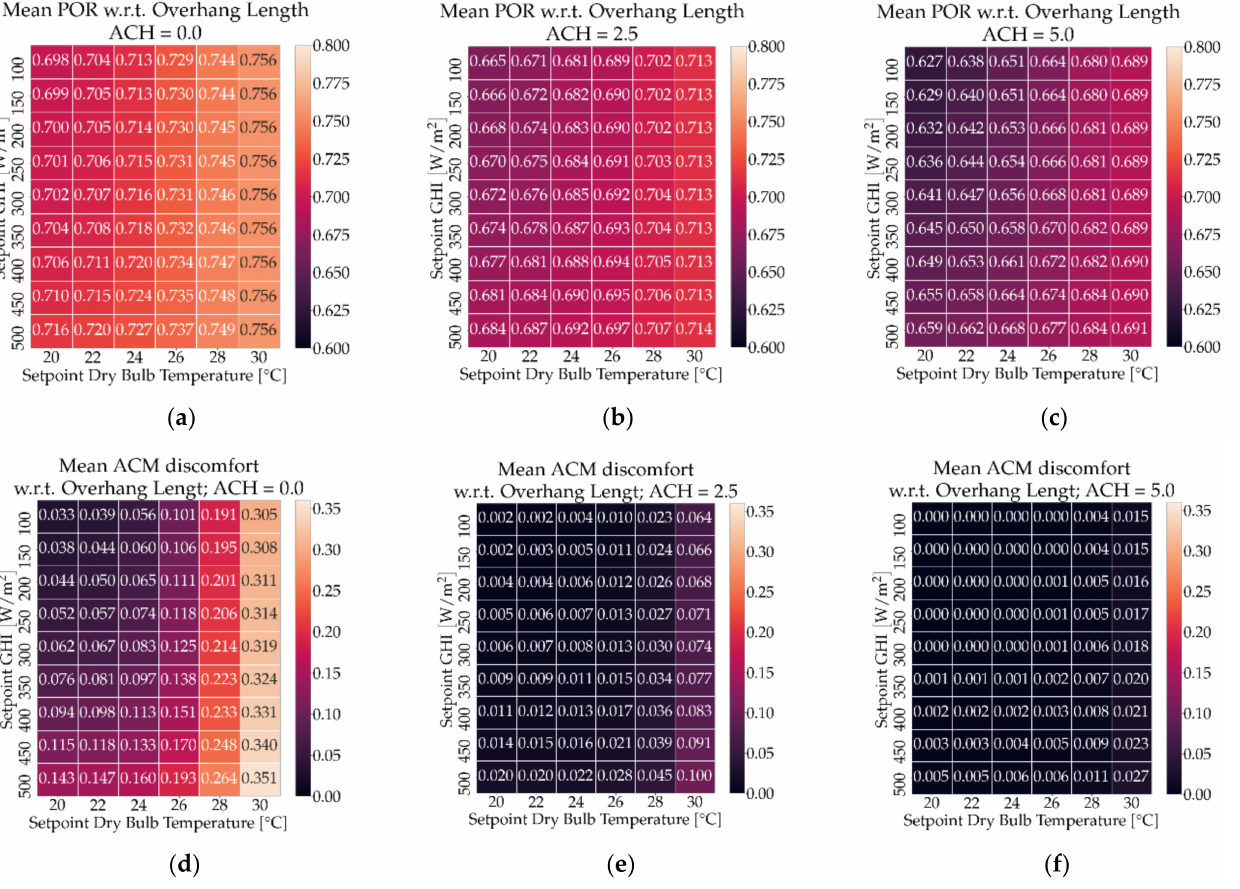
Figure 8. Simulated POR ( a – c ) and adaptive comfort model discomfort ( d – f ) in Rome. Outdoor temperature and global solar irradiation thresholds vary for activation of shade